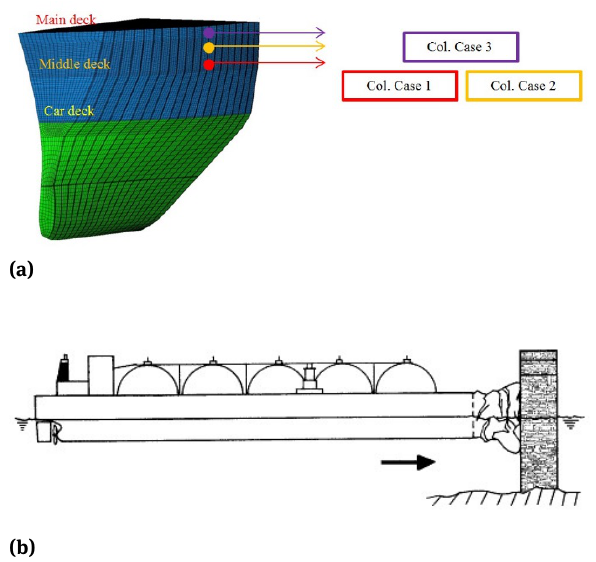
Figure 1: Collision types: (a) side collision [10] and (b) head-to-head collision